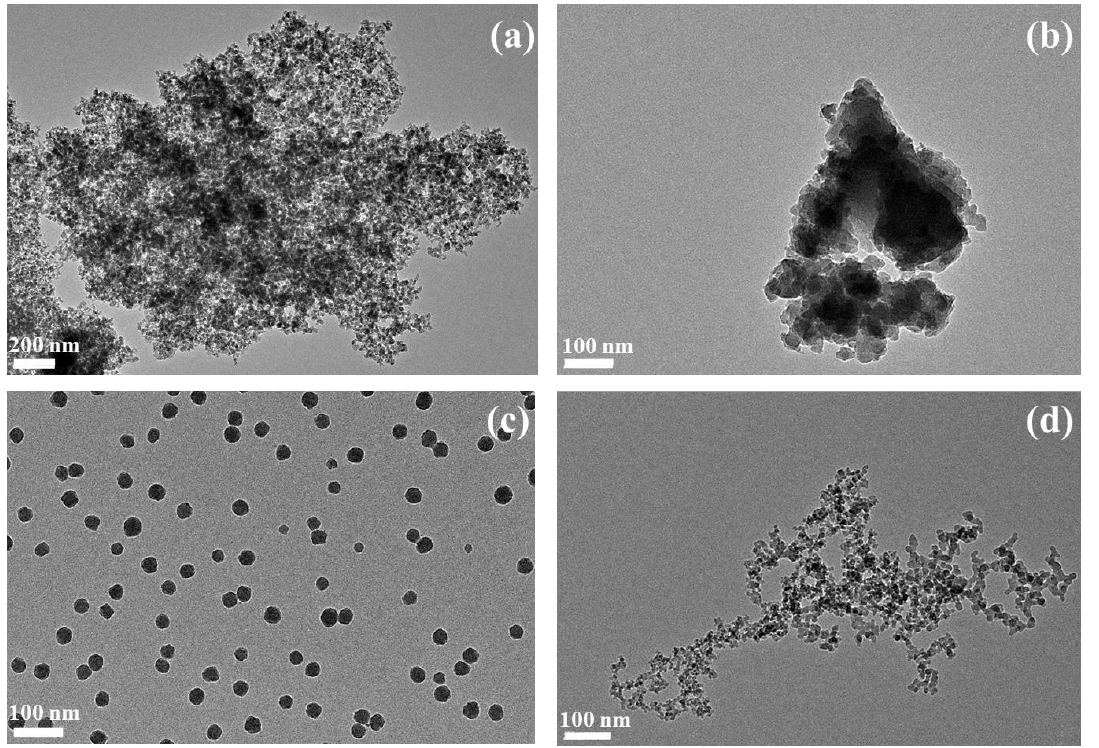
Figure 1. SAS characterization by transmission electron microscopy at Day 0 in water. ( a ) SPr 220 m 2 /g 23,000×. ( b ) MPr 55 m 2 /g 23,000×. ( c ) MC 140 m 2 /g 23,000×. ( d ) SPy 200 m 2 /g 23,000×.